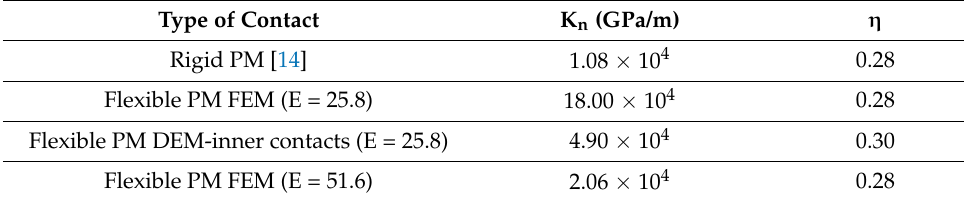
Table 1. Contact elastic properties for the particle models.